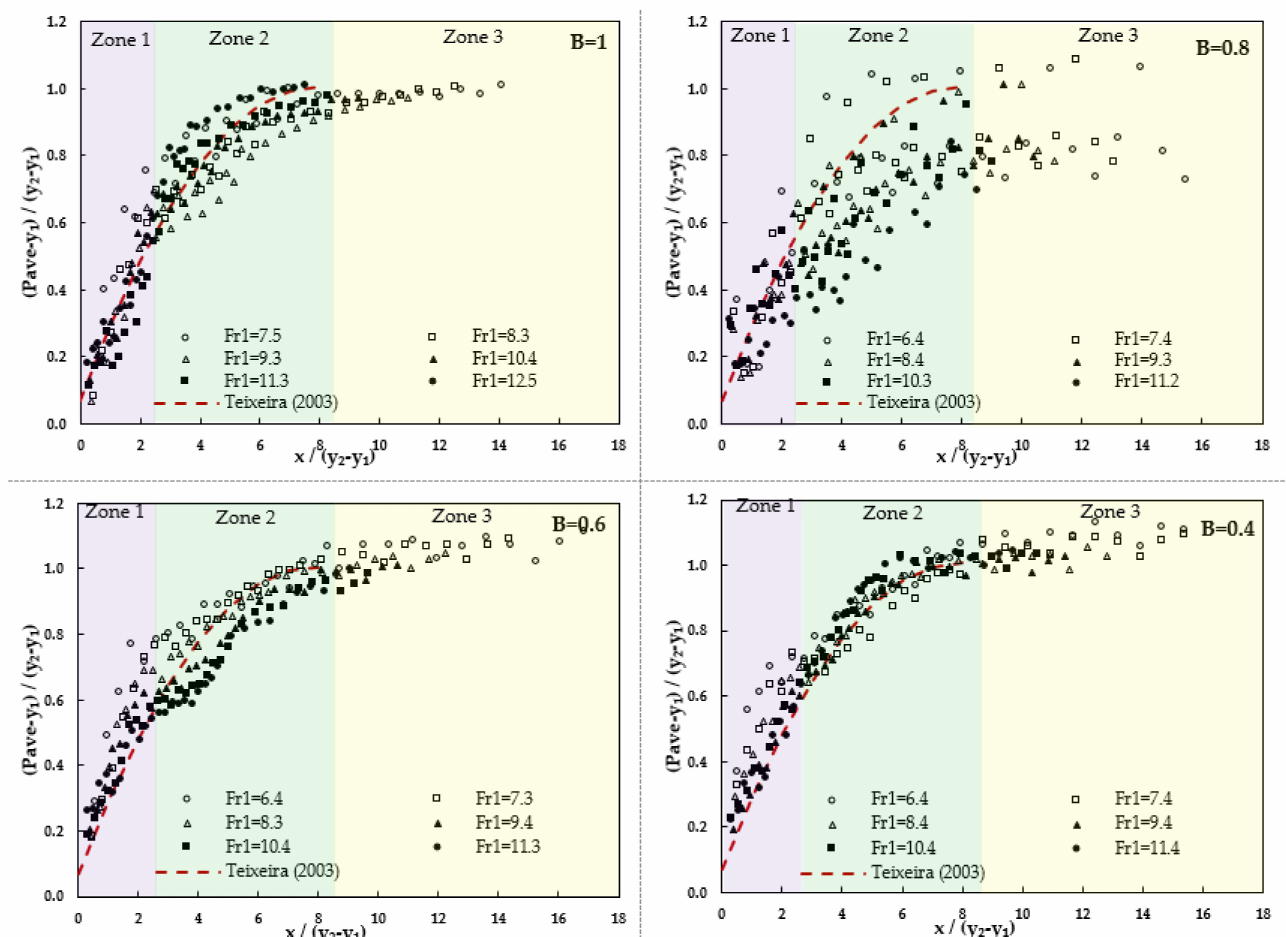
Figure 6. Average pressure distribution versus relative distance from the toe of the hydraulic jump according to expansion ratio and Froude